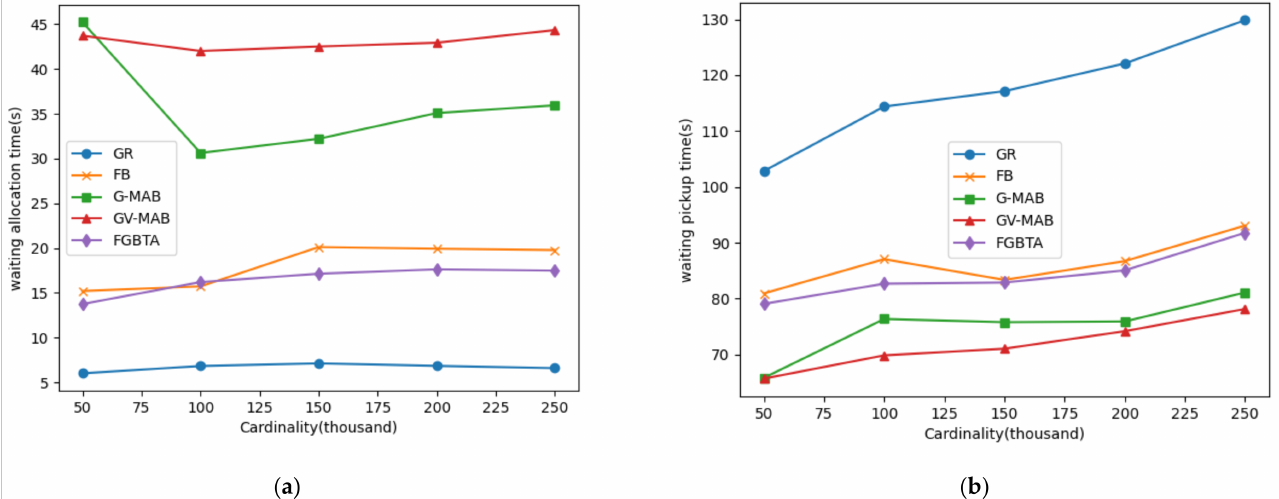
Figure 9. ( a ) Comparison of waiting allocation time; ( b ) Comparison of waiting pickup time. In Figure 9, the GR algorithm has the shortest waiting time for allocation because it is immediately allocated, but the distance between the matching sides is too long, resulting in the driving time being too long (waiting pickup time). On the contrary, the GV-MAB algorithm delays batch for the longest time, obtains a lot of crowdsourcing information, and has the shortest pick-up time. In the trade-off between these two factors, the FGBTA algorithm trades the shortest waiting time with shorter batch delay time and shorter pickup